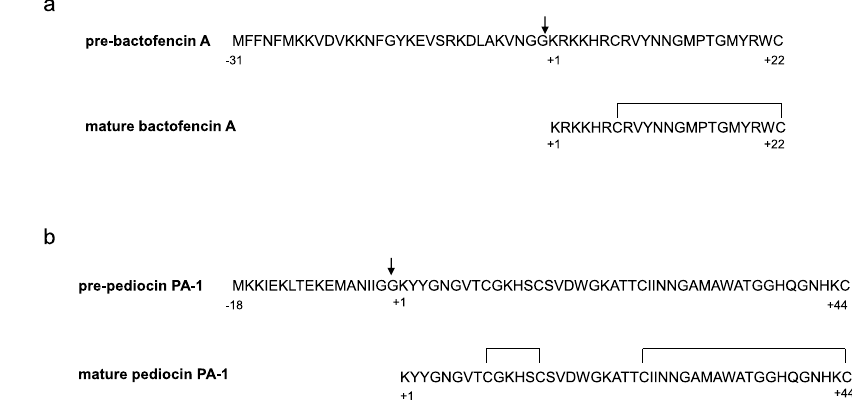
Figure 1. Amino acid sequence of ( a ) pre-bactofencin A and ( b ) pre-pediocin PA-1 and the mature sequences formed after processing of the leader peptide and oxidation of the cysteines. The black arrow indicates the leader peptide cleavage